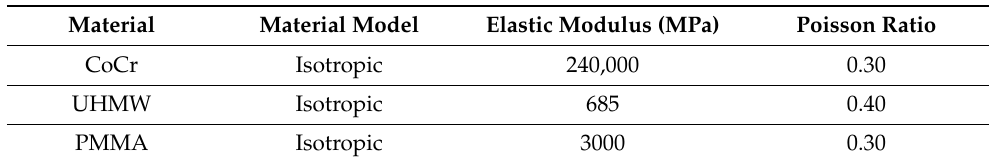
Table 1. Material properties of the implant components: CoCr = cobalt-chromium alloy, UHMWE = ultra-